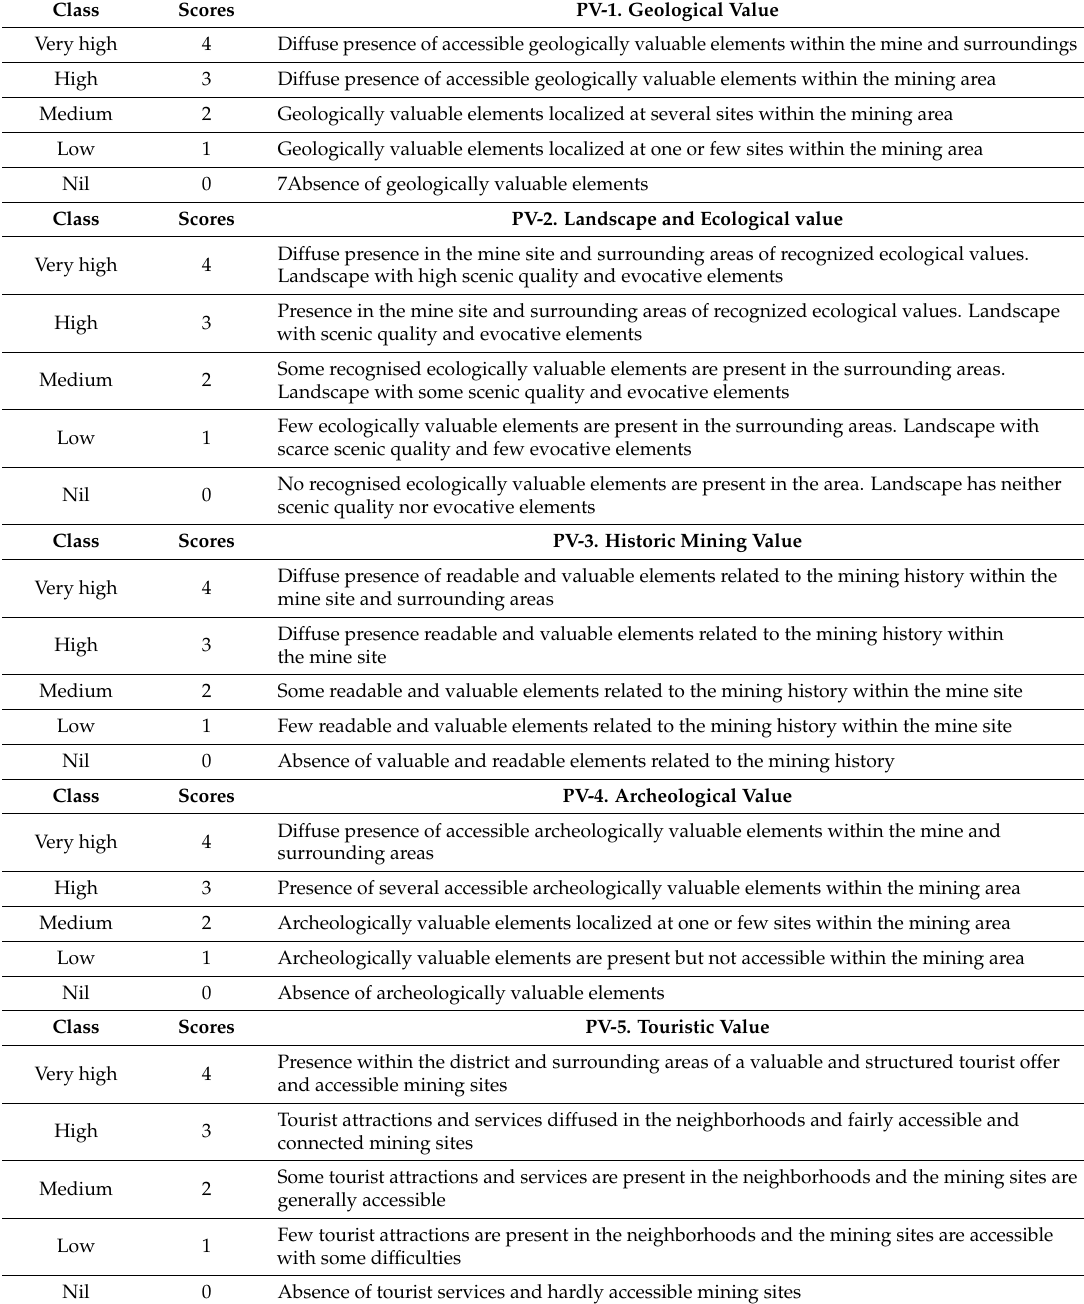
Table 2. Evaluation scores for positive values